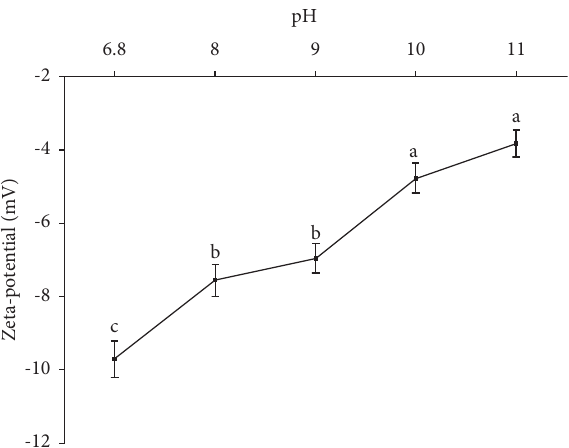
Figure 4: Effect of different pH values on the zeta-potential of peanut oil body (pH range of 6.8–11).